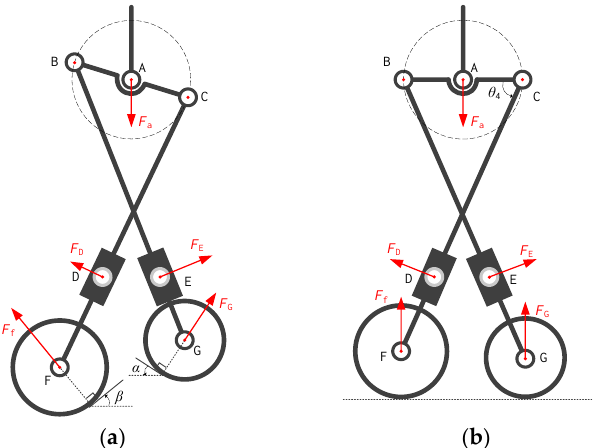
( c ) Figure 7. Schematic diagram of compliant bistable structure in different positions: ( a ) a static equi- librium position; ( b ) an unstable position; ( c ) another static equilibrium position. In the case of the compaction mechanism in the stiff state, as shown in Figure 6b, it indicates that parts JH and JN, and IK and BK, are bounded by a mechanical stop and the spring force. As a result, the two compaction segments (BG and CF) are distributed sym- metrically. Using the expressions 𝐹 𝑓 and 𝐹 𝐺 in Equations (8) and (9), the contact force in the stiff state can then be calculated according to Equations (14) and (15). Thus, the motion characteristics and response behavior of the underactuated compaction mechanism are acquired.